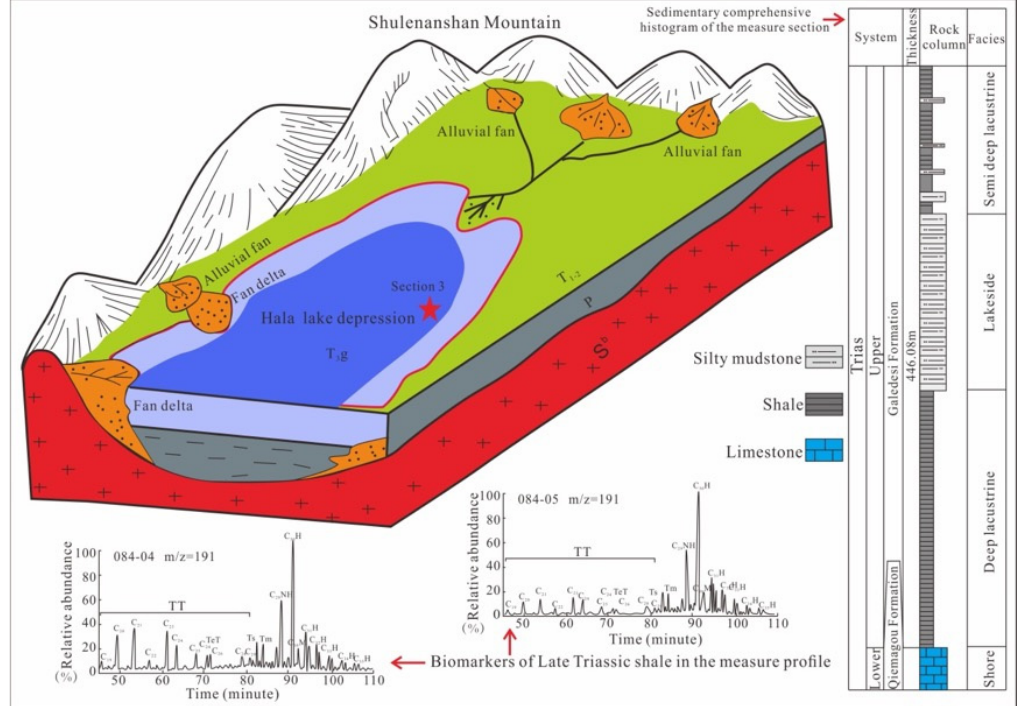
Figure 3. The sedimentary facies model of the Galedesi Formation shale in the Hala Lake Depression (Section 3 locations are shown in Figure 1).